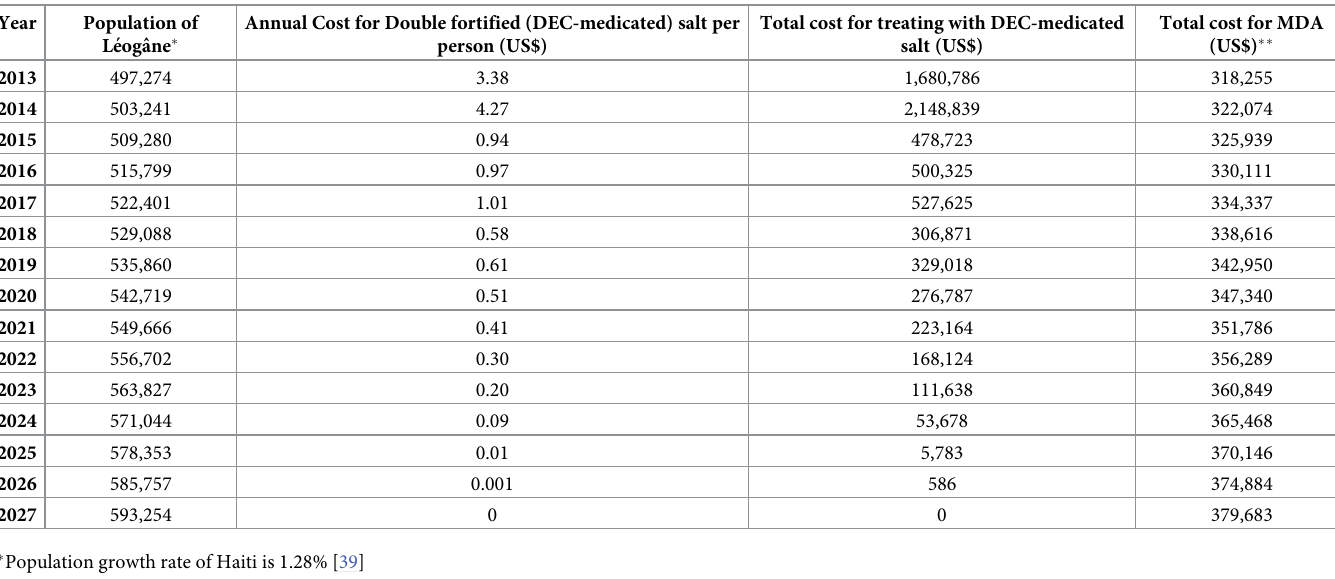
Table 5. Forecast of the population of Le´ogaˆne, annual cost of supplying double- fortified (DEC-medicated) salt per person per year, and total costs of treatment with DEC-medicated salt and MDA respectively for the years 2013–2027. The population growth rate for Haiti estimated in year 2015 (1.28%) was used in making the population size estimations shown in the Table, whereas a simple linear model based on the cost and revenue data connected with DEC-medicated salt production and sale (both fine- and coarse salt types) for the years 2013–2018 (Fig 2) was used to forecast the annual cost of salt-based DEC treatments per person and for the total population between 2019–2027.